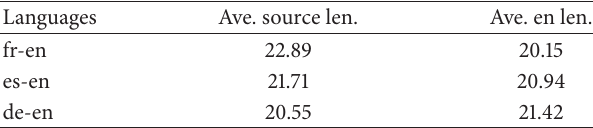
Table 5: Statistics of the first 10,000 WMT 2006 corpus.